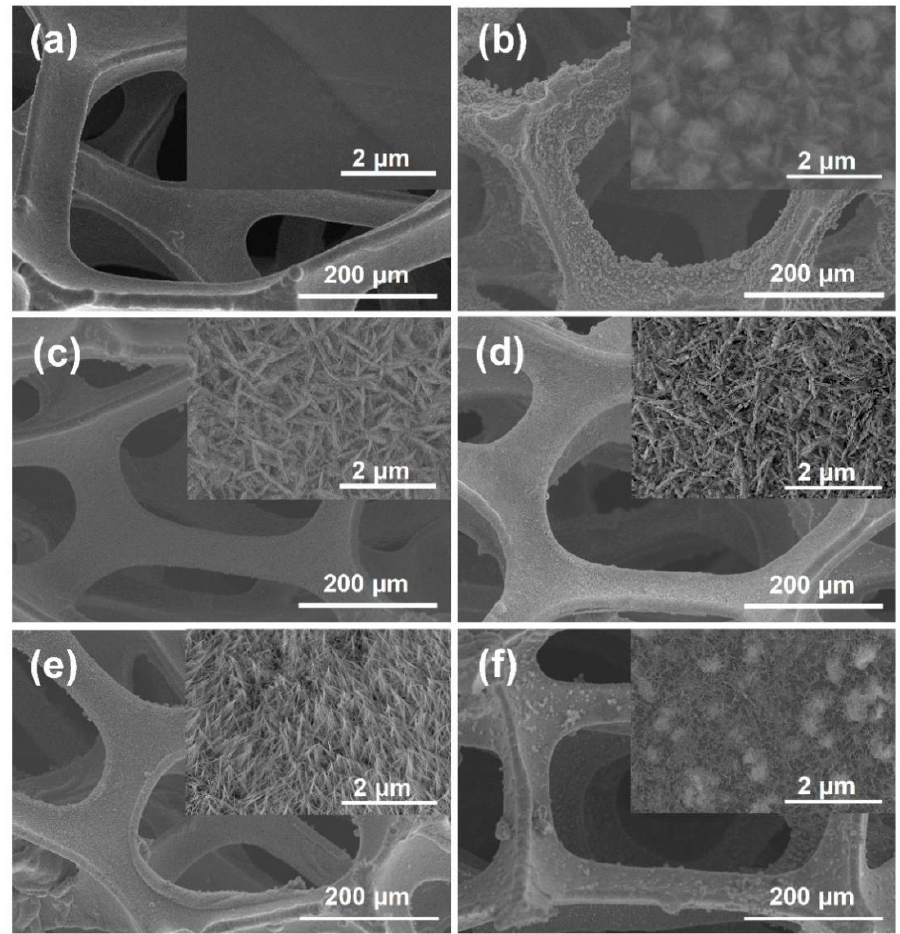
Figure 1. Scanning electron microscope (SEM) images of the samples at different Ni:Co ratios: ( a ) bare nickel foam; ( b ) 9:1; ( c ) 7:3; ( d ) 5:5; ( e ) 3:7; ( f ) 1:9.